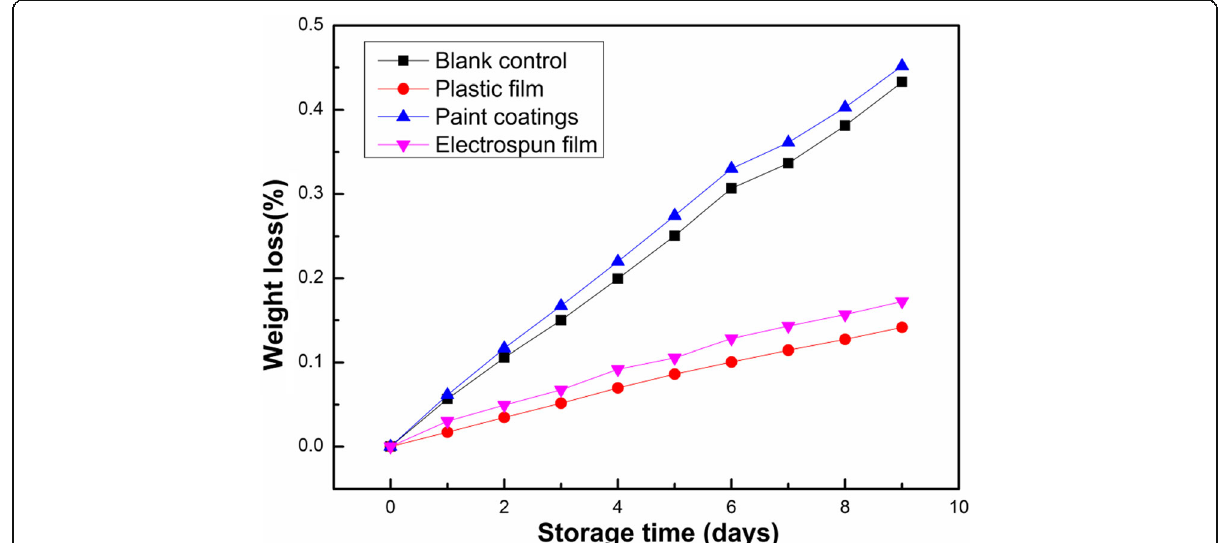
Fig. 7 The weight loss ratios of strawberries in different groups during storage at ambient temperature